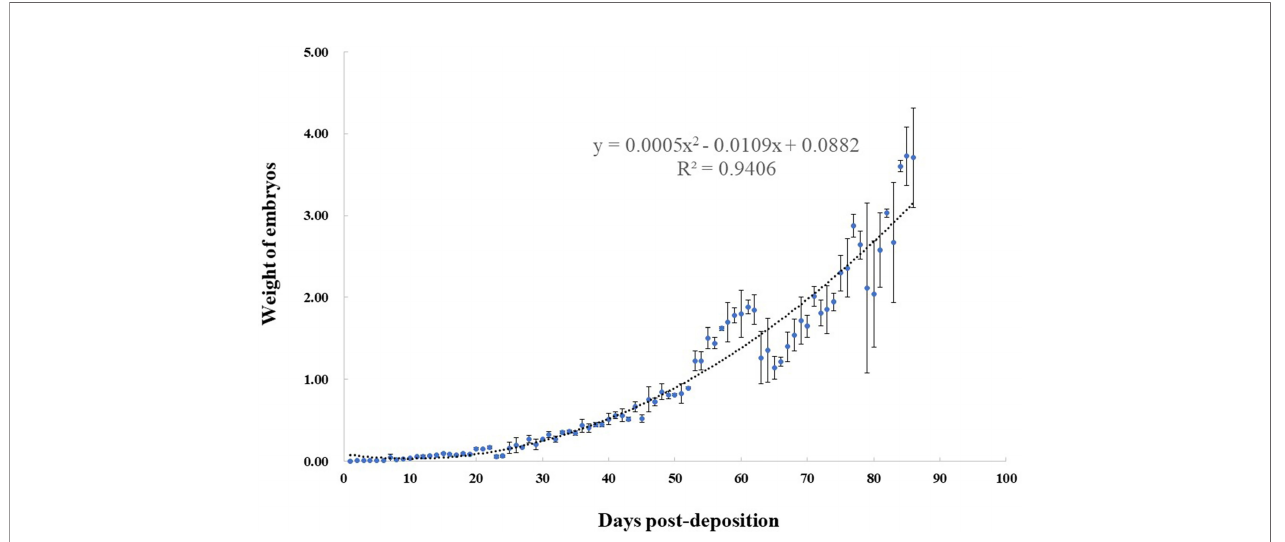
FIGURE 2 | Relationship between weight (g) and days post-deposition (dpd) for Okamejei kenojei embryos. The curve was fi tted by y = 0.0005x 2 - 0.0109x + 0.0882, (R² =